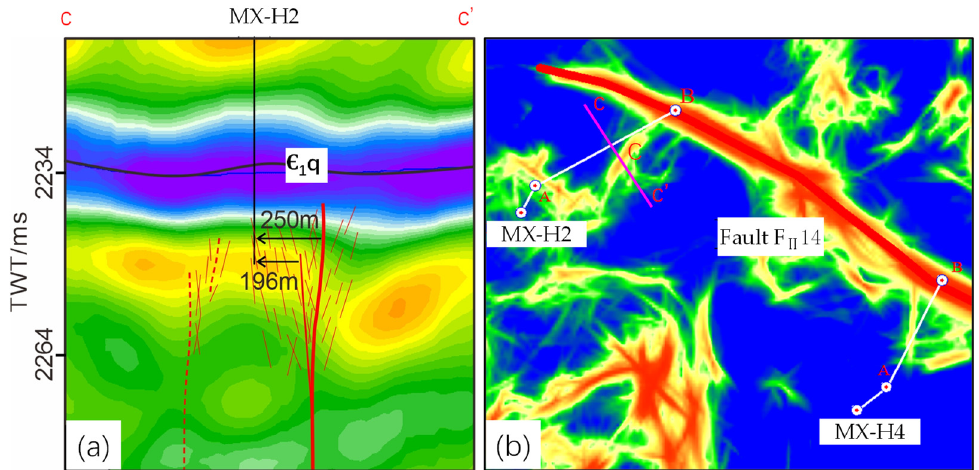
Figure 9. ( a ) Seismic section across the mud loss point of well MX-H2 (the well is 250 m far away to the major fault; Є 1 q: base of the Cambrian); ( b ) planar seismic illumination attribute showing the horizontal well locations at the fourth member of the Denying Formation in Anyue Gasfield (the horizontal interval from A to B; C: mud loss point).